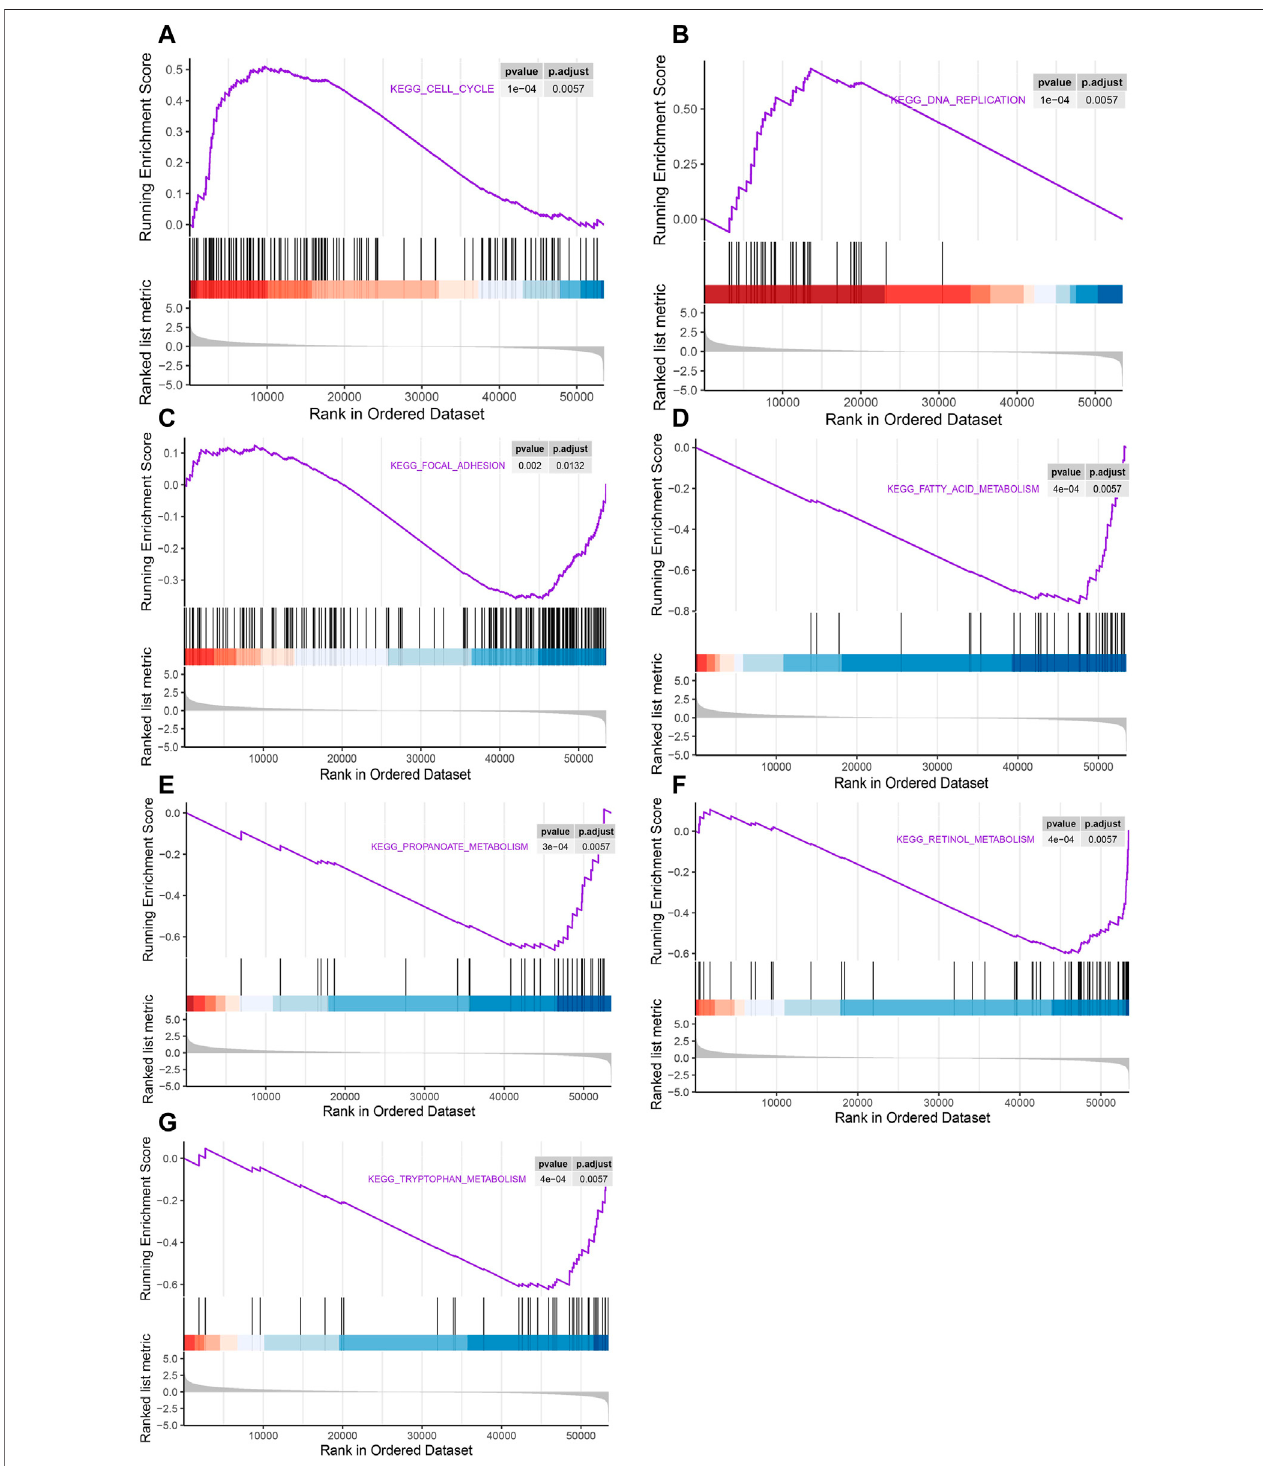
FIGURE 10 | Gene set enrichment analysis (GSEA) of pathways associated with LSM4 expression. The LSM4 expression was signi fi cantly correlated with the cell cycle, DNA replication, focal adhesion and multiple metabolism-associated pathways (A – G) .